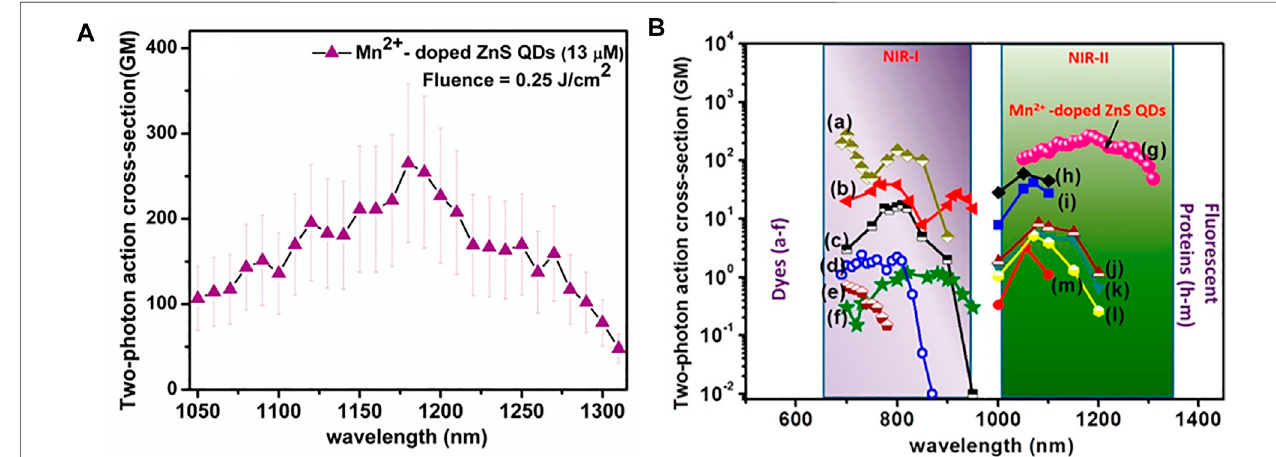
FIGURE 5 | (A) 2PA spectrum of Mn 2+ -doped ZnS QDs in the range from 1050 to 1300 nm reported by Subha et al. (B) Comparison of σ 2 values in Mn 2+ -doped ZnS QDs (curve g) with other standard chromophores (curves a – f) and fl uorescent proteins (curves h – m): (a) Rhodamine B, (b) Fluorescein, (c) Coumarin 307, (d) Cascadeblue,(e)Dansyland(f)LuciferYellow),and(h)tdTomato,(i)mBanana(j)mRFP(k)mCherry(l)mStrawberry(m)mTangerine).Reprintedwithpermission fromref. (Subha et al., 2013). Copyright 2013 American Chemical Society.